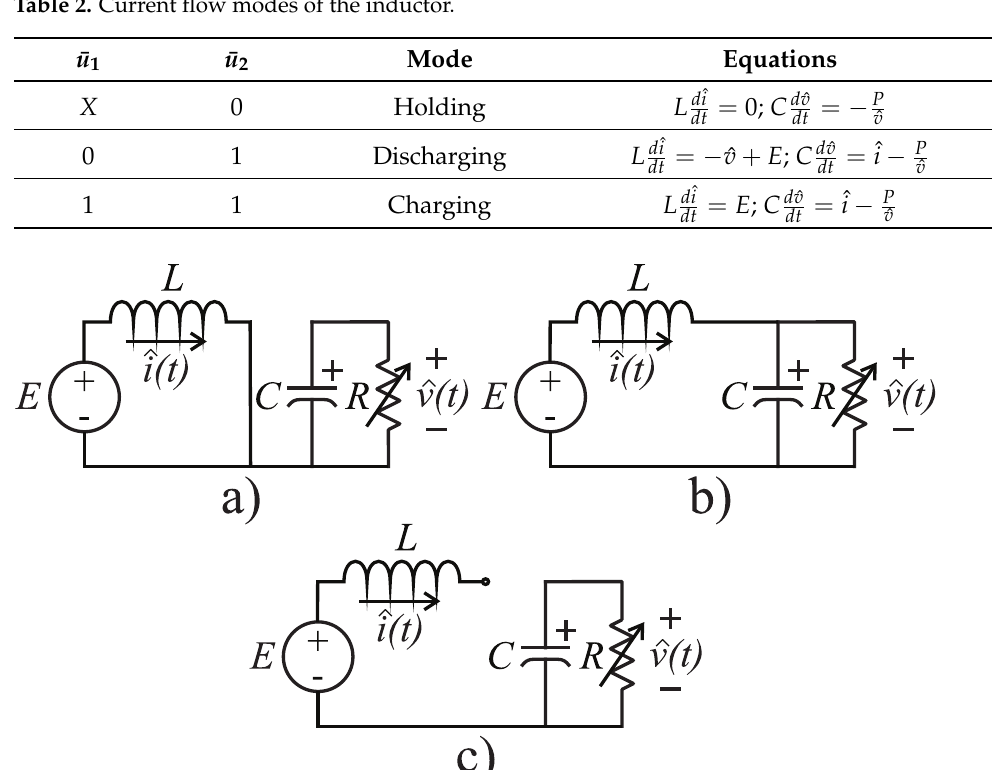
Figure 4. Illustration of the inductor current flow modes: ( a ) Charging, ( b ) discharging, and ( c )